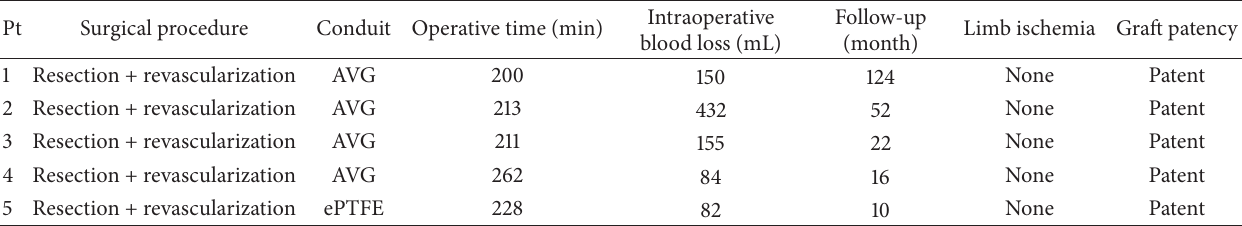
Table 2: Surgical procedures, intraoperative findings, and long-term follow-up results.